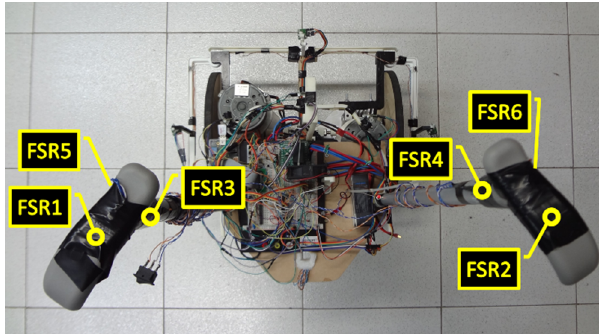
Figure 5. Distribution of FSR 400 sensor at the prototype.